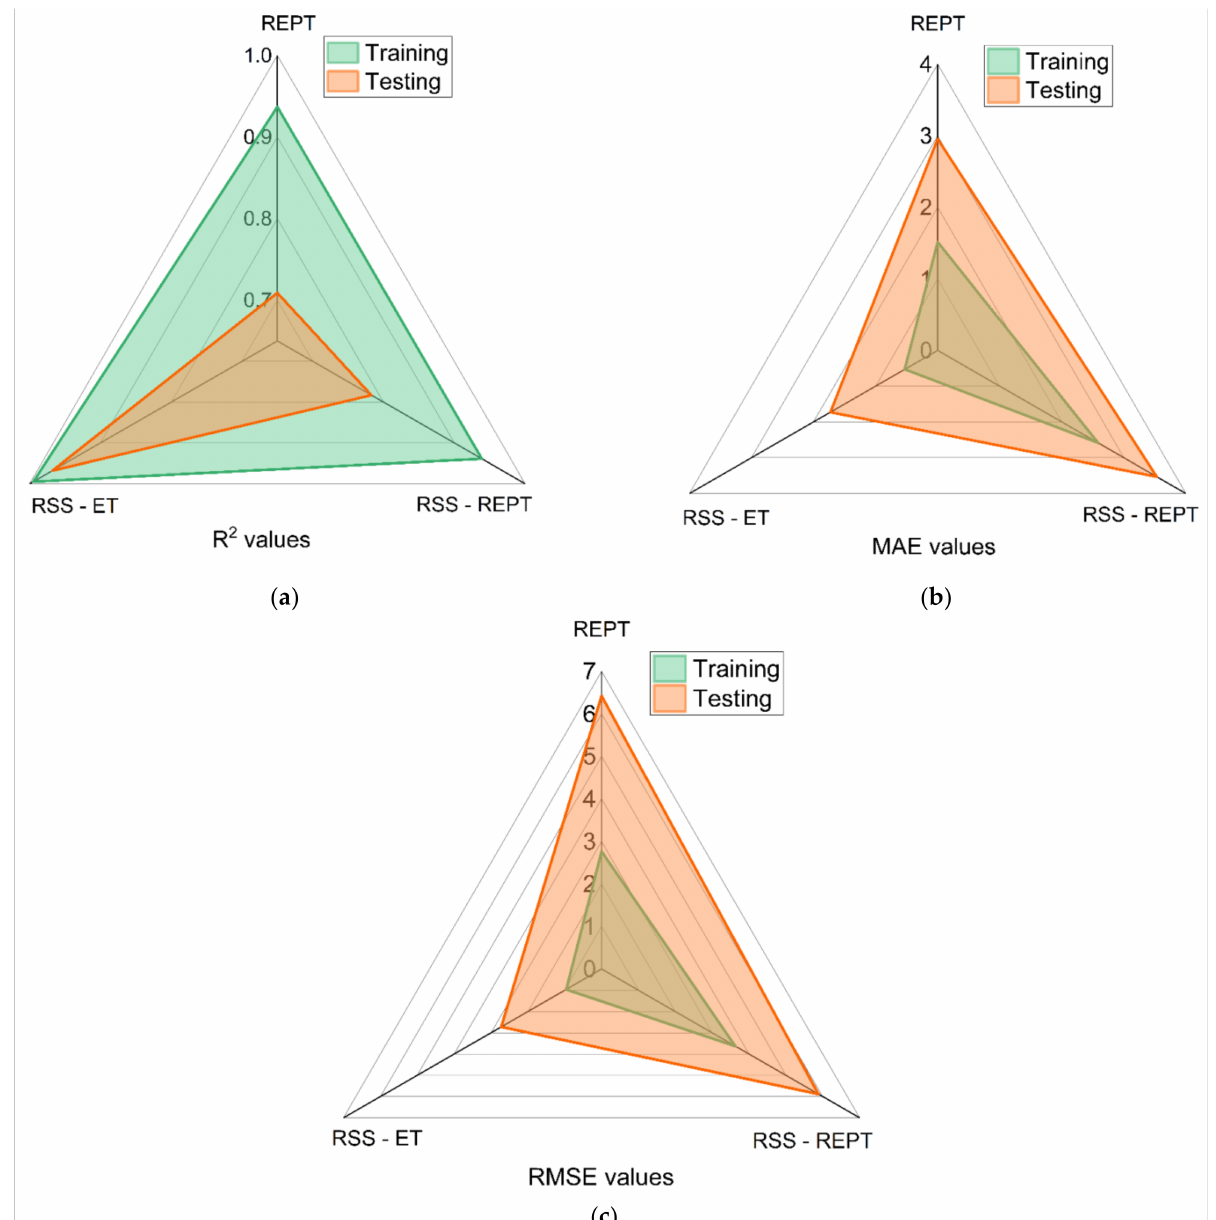
Figure 7. Comparative analysis of R 2 ( a ), RMSE ( b ), and MAE ( c ) of the developed